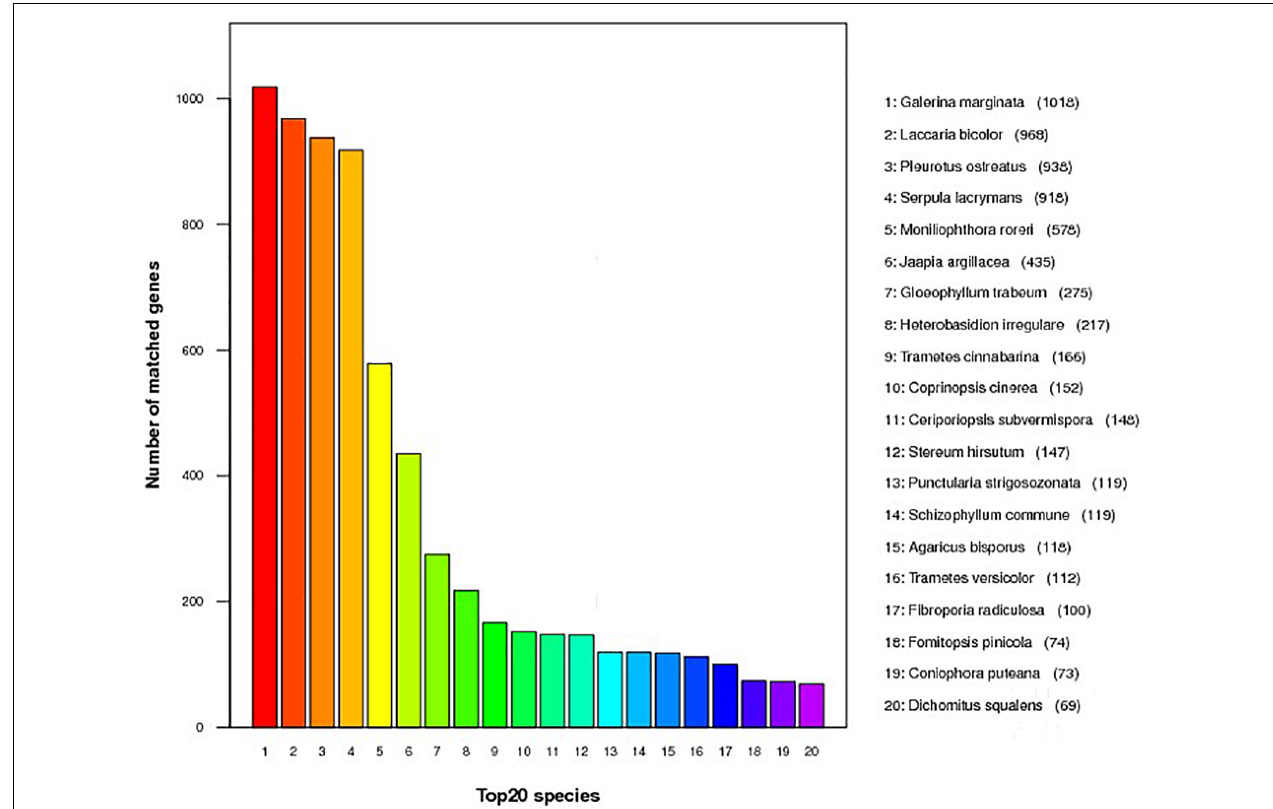
FIGURE 2 | Predicted proteins from Sarcomyxa edulis genome to the National Center for Biotechnology Information non-redundant protein database among different fungal species.